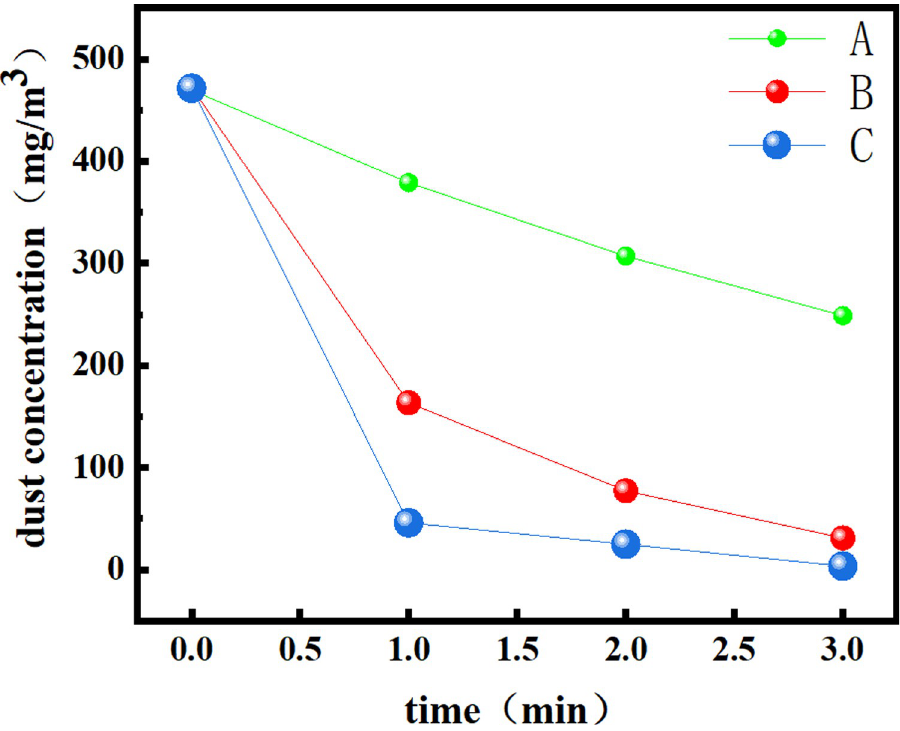
Fig 13. Change in the total dust concentration measured for each of the three dust removal methods.